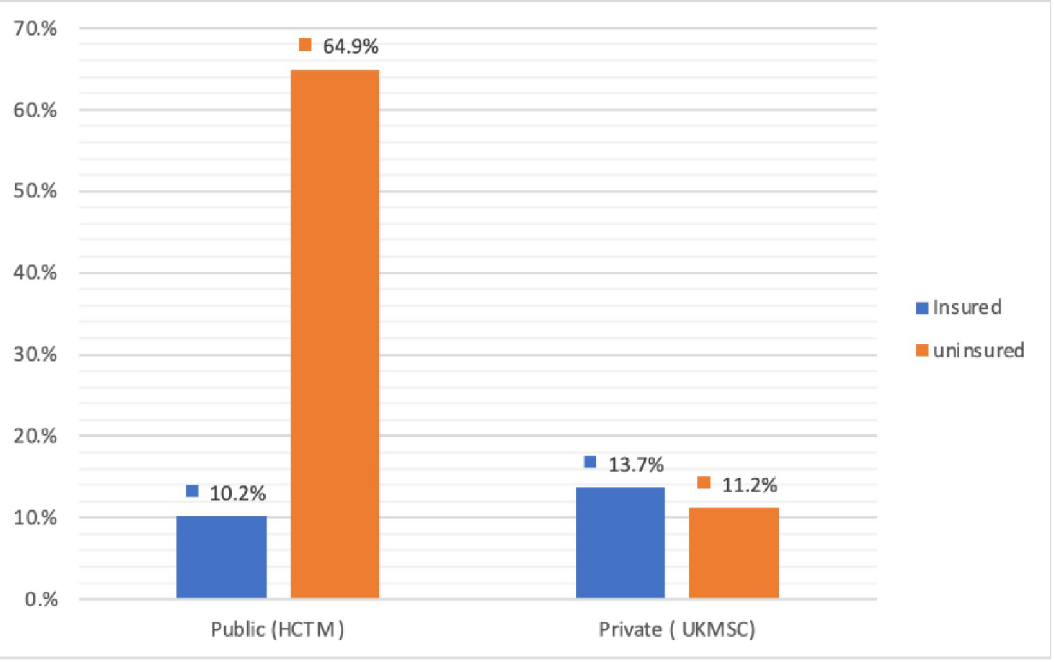
Fig 1. Insurance status of T2DM patients at HCTM and UKMSC.